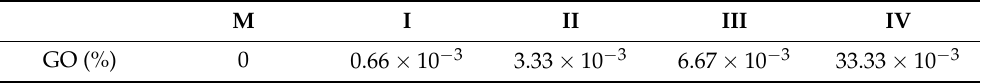
Table 3. Percentage composition of graphene oxide in whey–gelatin-based